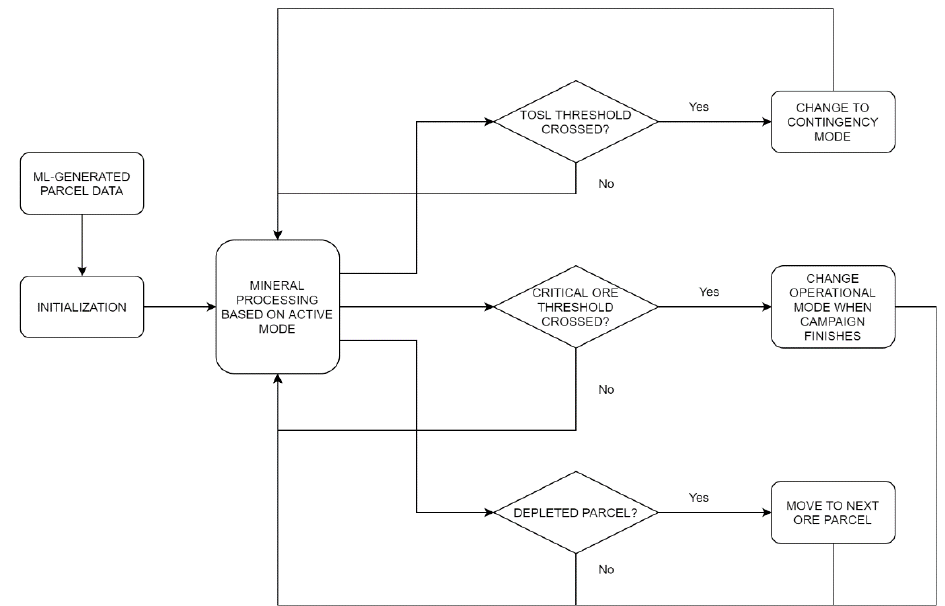
Figure 8. High level representation of the DES flow model.